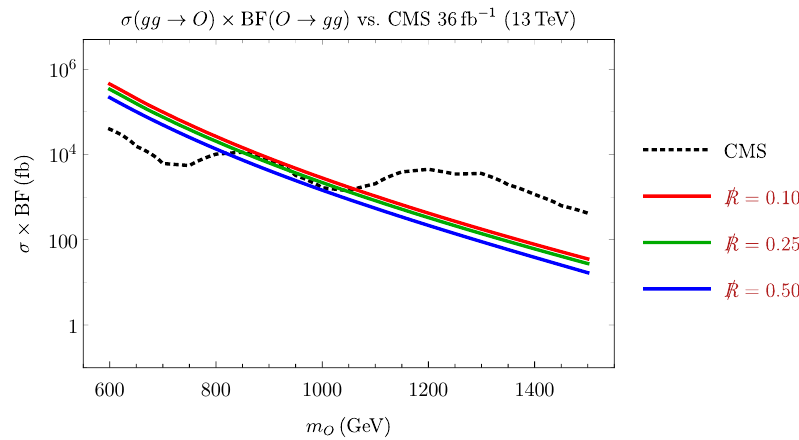
Figure 11. Cross sections in Benchmark 1–3 of single scalar sgluon production with subsequent decay to gluons compared to exclusion bound from CMS 36 fb − 1 ( 13 TeV) dijet resonance search for color-octet scalars assuming σ ( O ) = σ eff ( gg → O ) and BF ( O → gg ) = 1